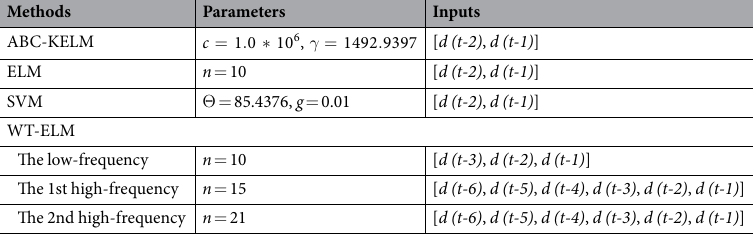
Table 2. The parameters and inputs of the four compared methods.